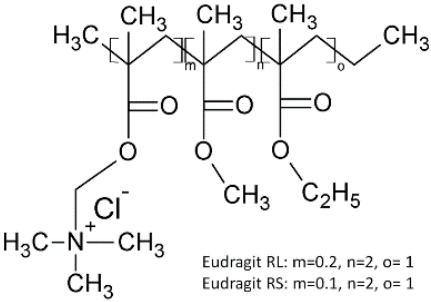
Figure 9. Chemical structure of Eudragit ® RL and RS [114].